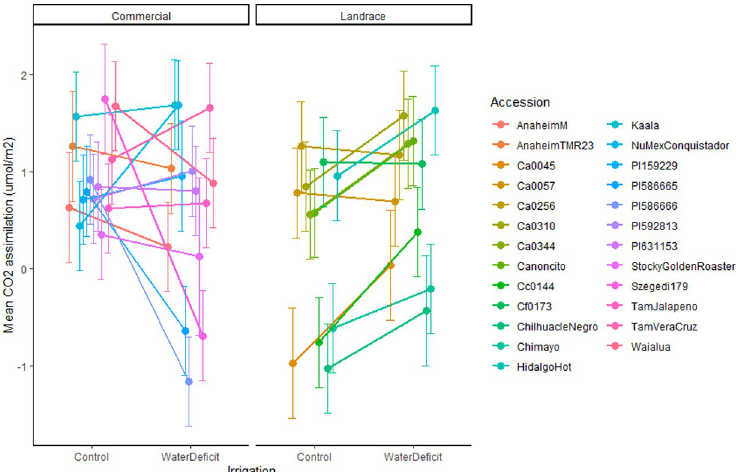
Fig 2. Interaction plot of estimated marginal means with standard error bars for CO 2 assimilation (log transformed) in a greenhouse soil water deficit experiment on chile pepper ( Capsicum sp.) at the Ohio State University. Accessions are separated by domestication